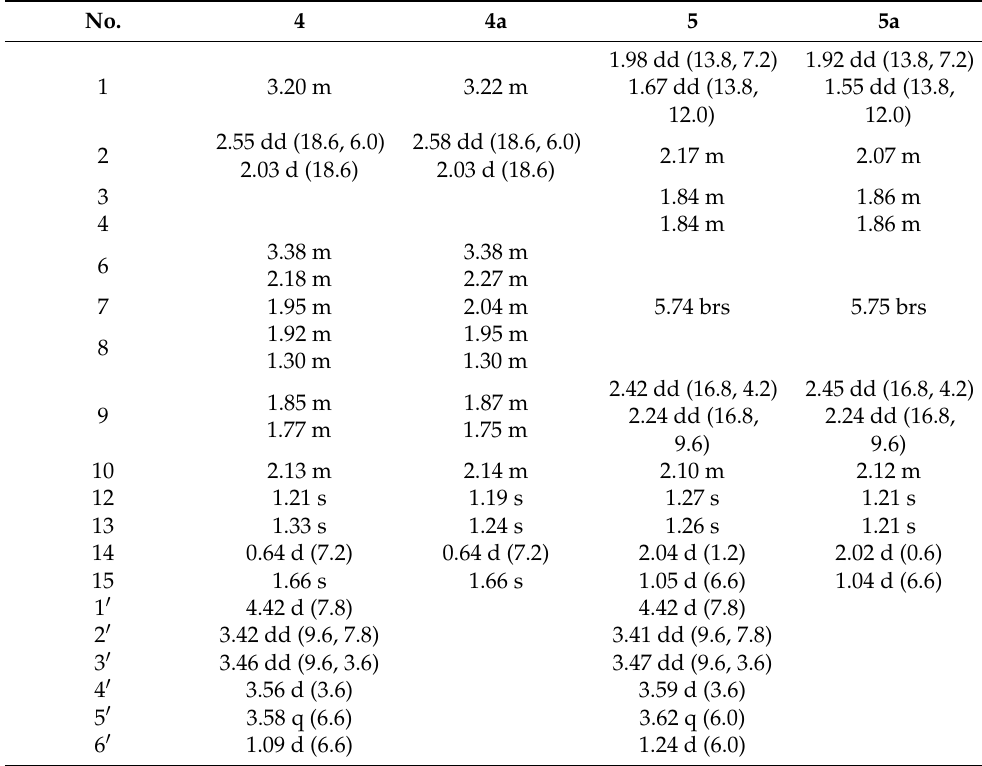
Table 3. 1 H NMR data of compounds 4 , 4a , 5 , and 5a in CD 3 OD ( δ in ppm, J in Hz).